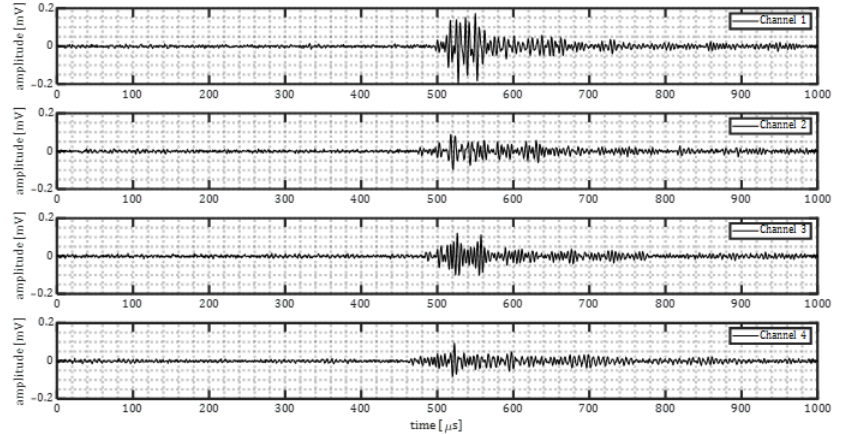
Figure 10. The corrosion induced signals for baseline plate experiment.